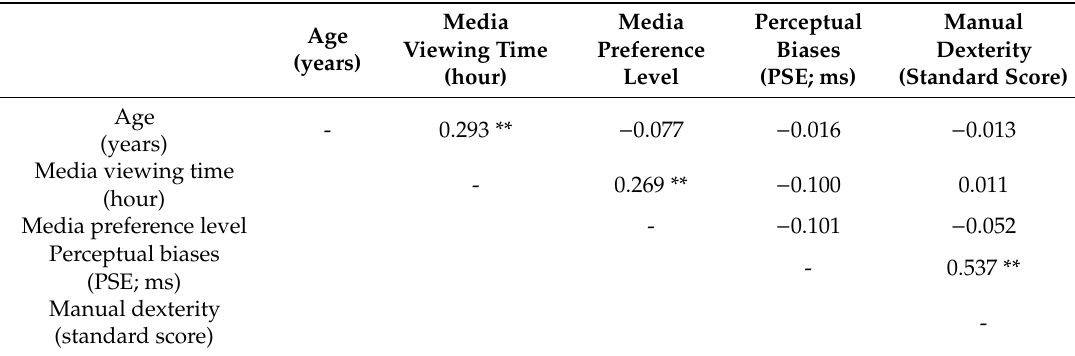
Table 3. Correlation matrix